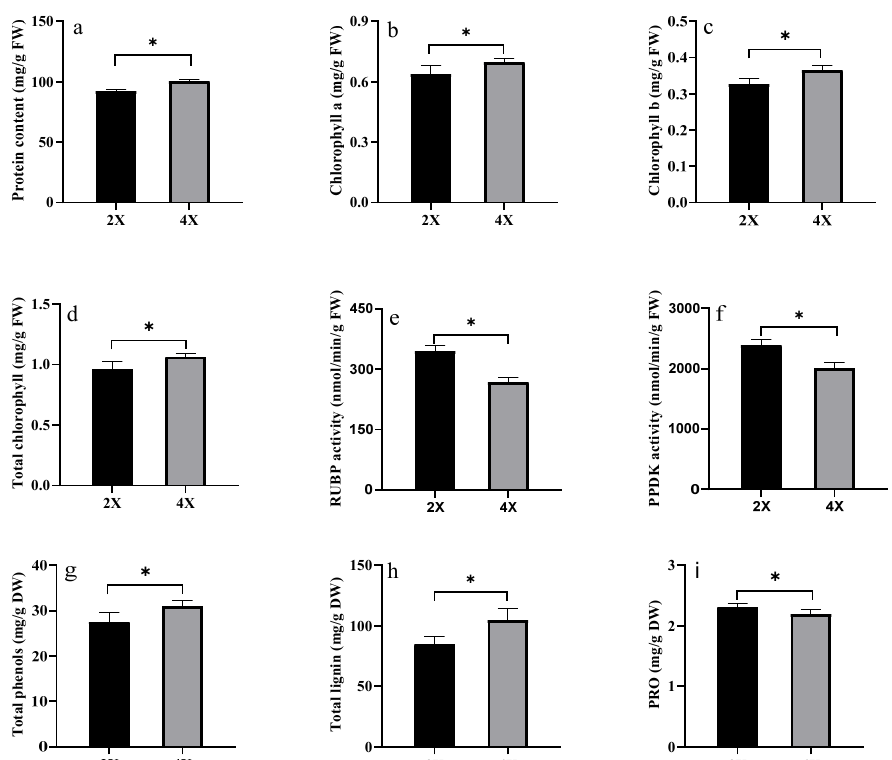
Figure 2. The physiological and biochemical indices of leaves obtained from diploid and tetraploid plants ( a – i , protein content, chlorophyll a, chlorophyll b, total chlorophyll, activity of Rubisco, activity of pyruvate phosphate dikinase (PPDK), total phenolics level, lignin level, proline content). * was the significance determined at p < 0.01 (n = 3).